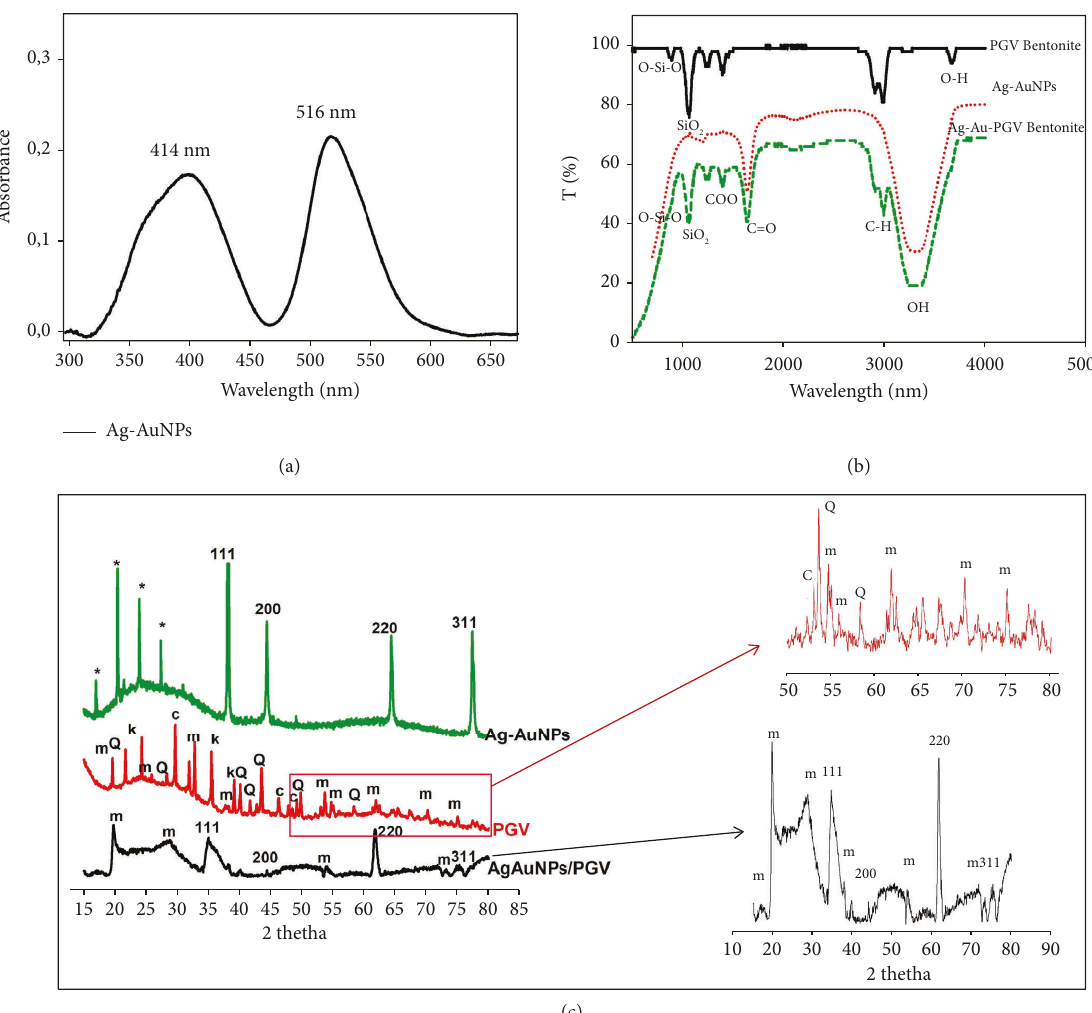
Figure 2: Presentation of UV/Vis of Ag-AuNPs (a), overlayed FTIR of PGV bentonite, Ag-AuNPs, Ag-AuNP-PGV (b), and overlayed XRD of PGV bentonite, Ag-AuNPs, and Ag-AuNPs/PGV bentonite with inset showing tiny peaks of PGV and Ag-AuNPs/PGV